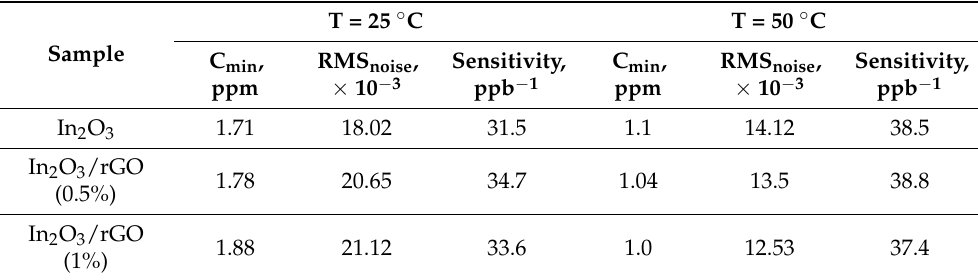
Table 1. Minimum detectable NH 3 concentration c min , RMS noise , and sensitivity of the sensors measured at 25 ◦ C and 50 ◦ C under dry air conditions and UV